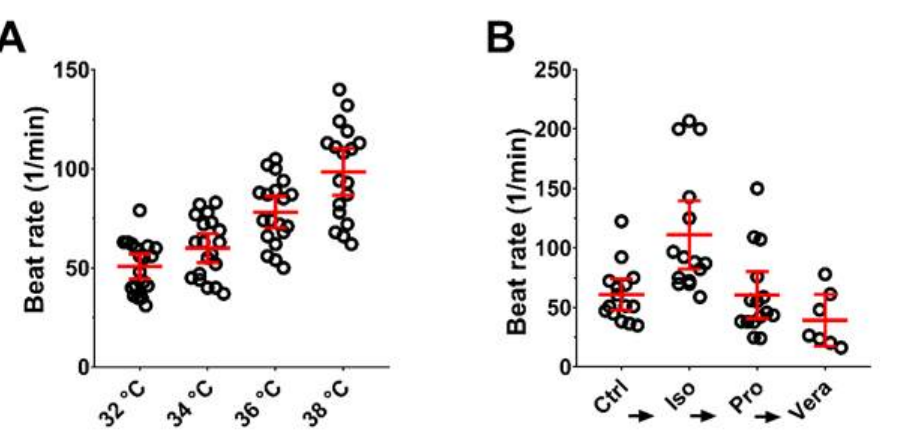
Figure 5. hPSC-CMC respond with altered beat rate to external stimuli. ( A ) Beat rate of single hPSC- CMC (n = 18) in the temperature range of 32–38 ◦ C. ( B ) Beat rate of hPSC-CMC after subsequent external adding of 1 µ m of the drugs isoproterenol (Iso, n = 15), propranolol (Pro, n = 15), and verapamil (Vera, n = 7) to untreated controls (Ctrl, n = 15). Circles show individual measurements; red marks show the mean ± 95% CI.